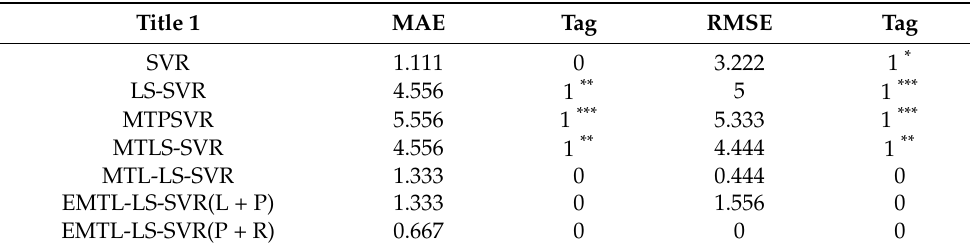
Table 4. Comparison results between EMTL-LS-SVR(L + R) and other algorithms on average rank